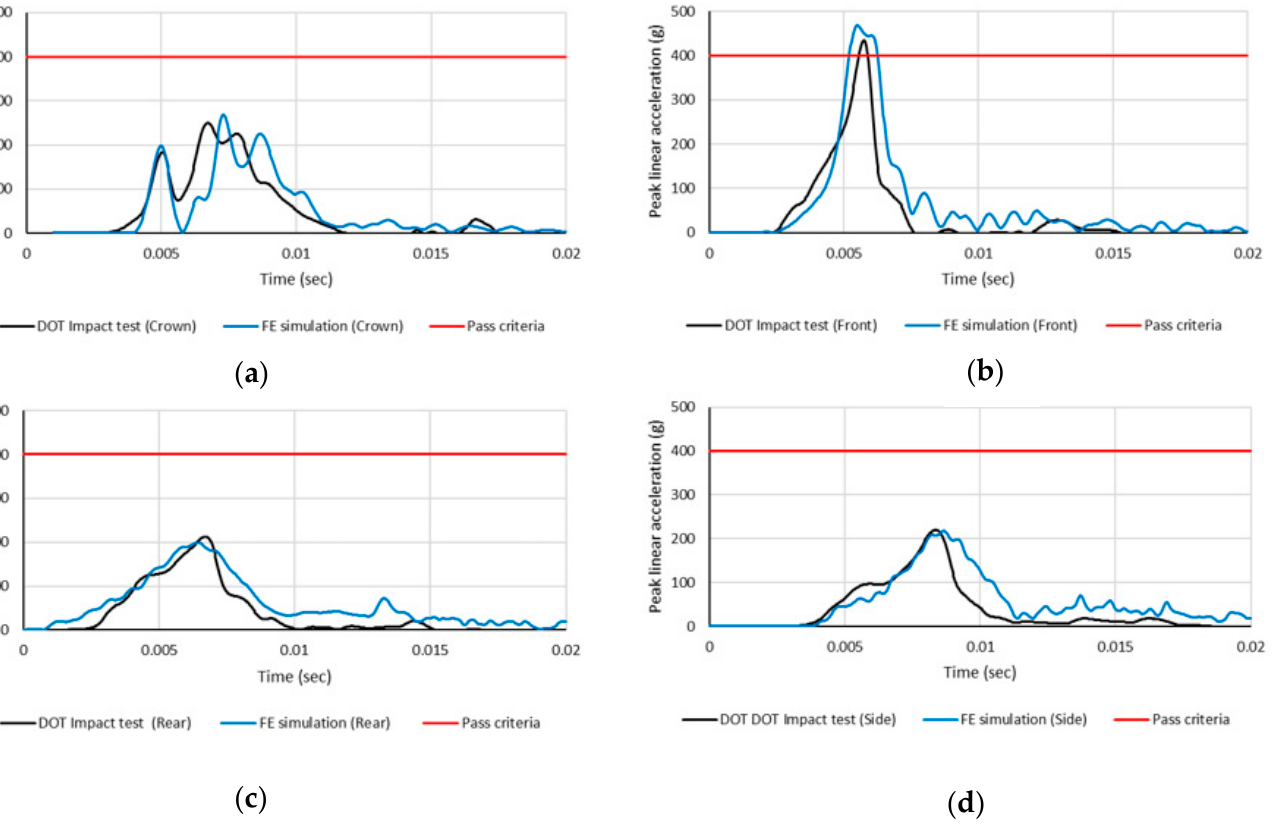
Figure 7. Comparisons of the linear acceleration obtained from the DOT drop test and the finite element simulations at ( a ) crown, ( b ) front, ( c ) rear, and ( d ) side impact locations.